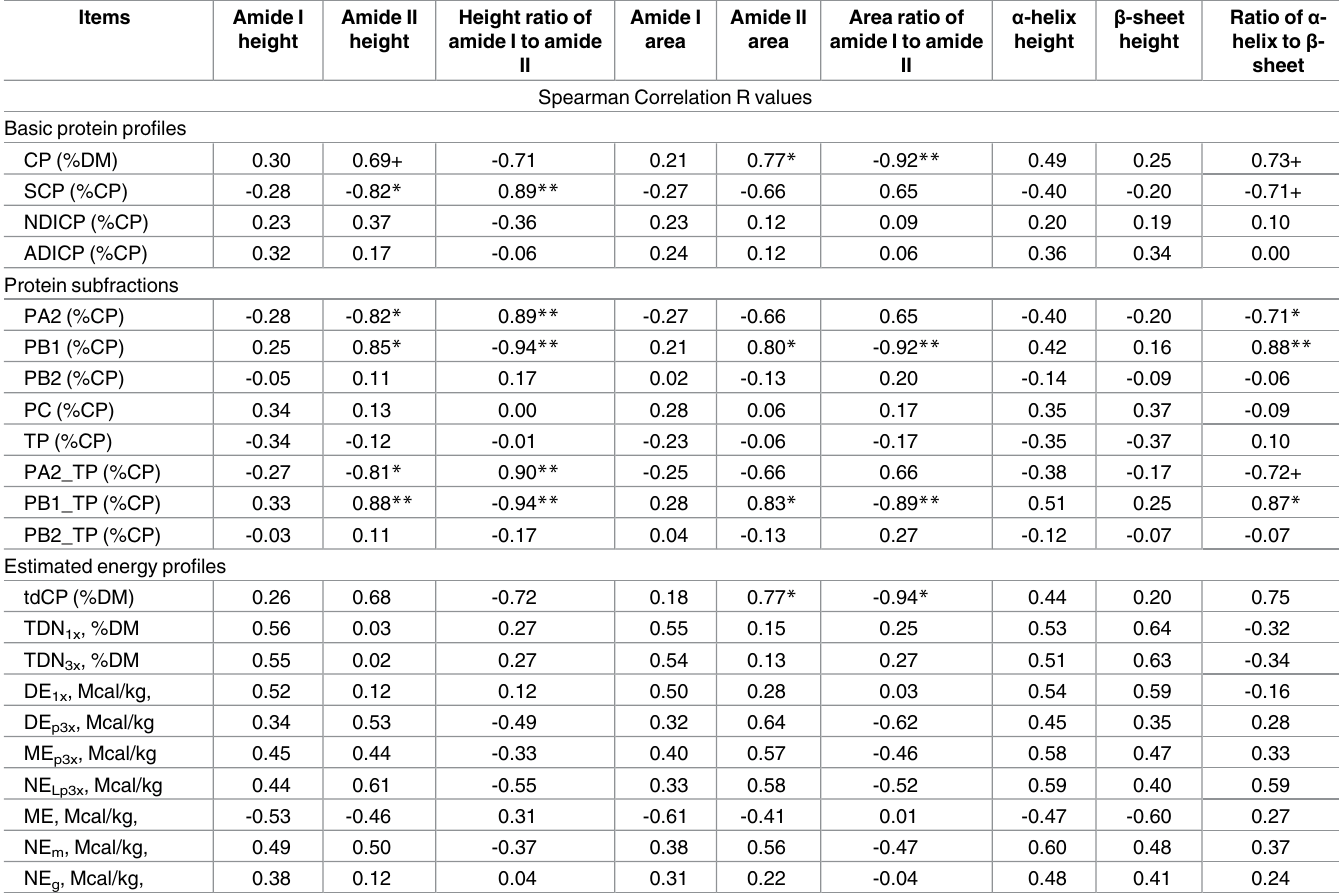
Table 1. Correlations between protein molecular spectral profiles and protein profiles, protein subfraction and estimated energy profiles in pellet- ing-processed canola meal using ATR-FT/IR.